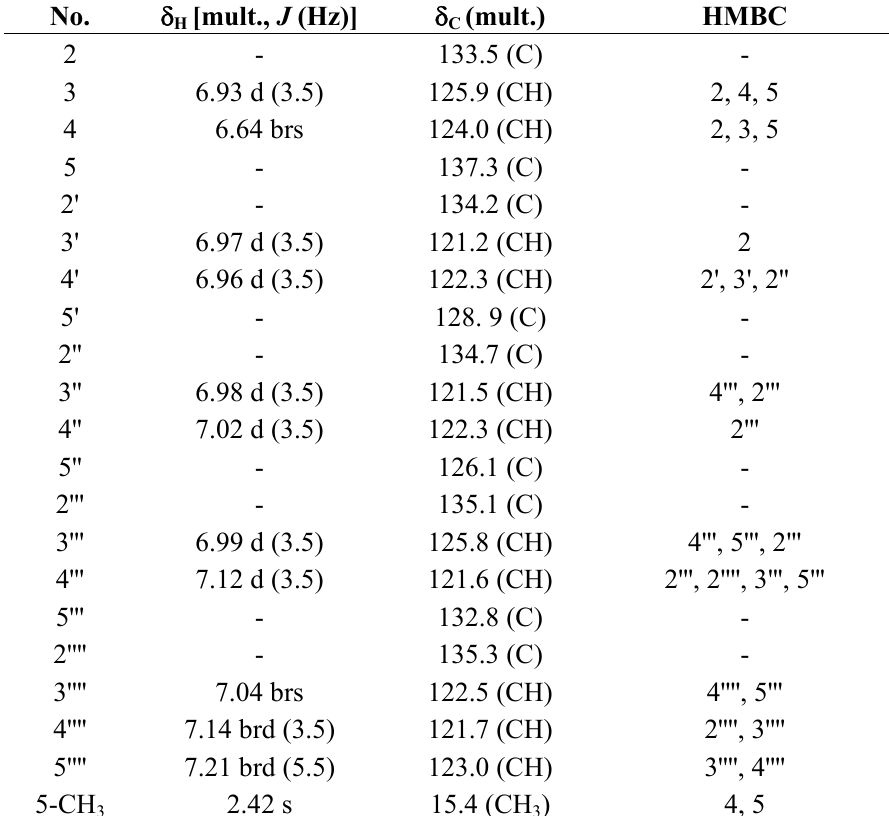
Table 1. NMR spectral data for compound 1 (CDCl